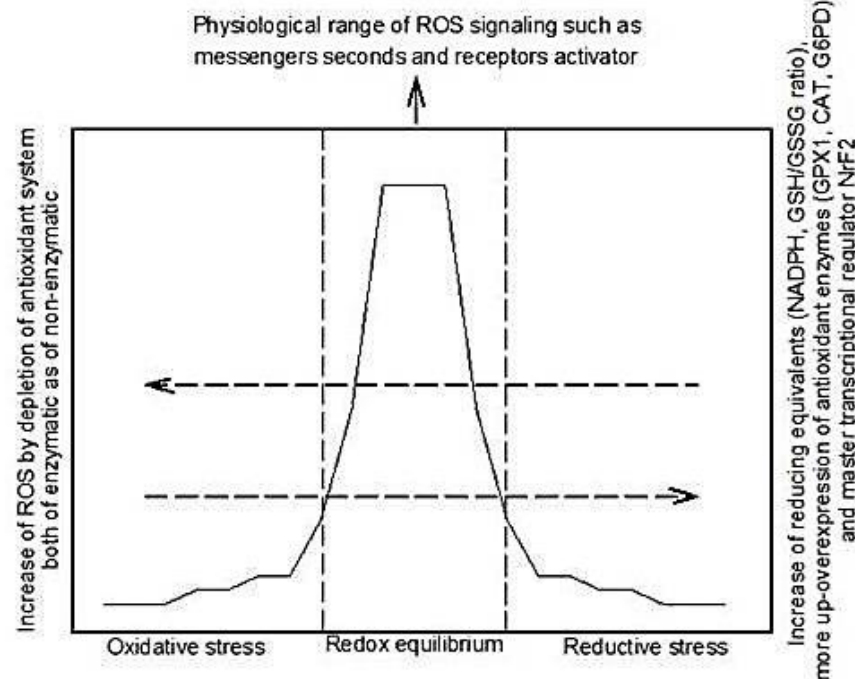
Figure 1. The redox equilibrium is essential for cellular homeostasis; moderate reactive oxygen species (ROS) production leads to their effects as second messengers. However, ROS overproduction and/or depletion or the antioxidant enzymatic and non-enzymatic systems may lead to oxidative stress. Excess reducing equivalents such as glutathione reduced (GSH)/glutathione oxidized (GSSG) ratio and nicotinamide adenine dinucleotide reduced (NADPH) can depleted all ROS driving to reductive stress by overexpression of antioxidant enzymatic system. Moreover, chronic reductive stress may induce an oxidative stress and stimulated reductive stress by a feedback regulation. Nevertheless, this process it is not yet clearly understood. Adapted from Lubos et al., 2011 [2] and Brewer et al., 2011 [3].